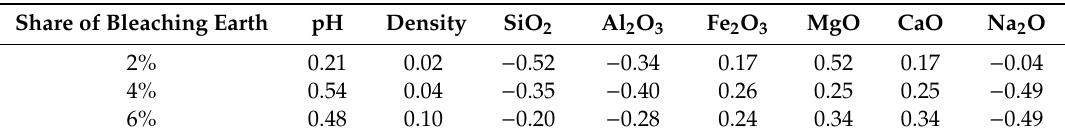
Table 4. Statistical analysis and the correlation of components of bleaching earths in phosphorus reduction in the